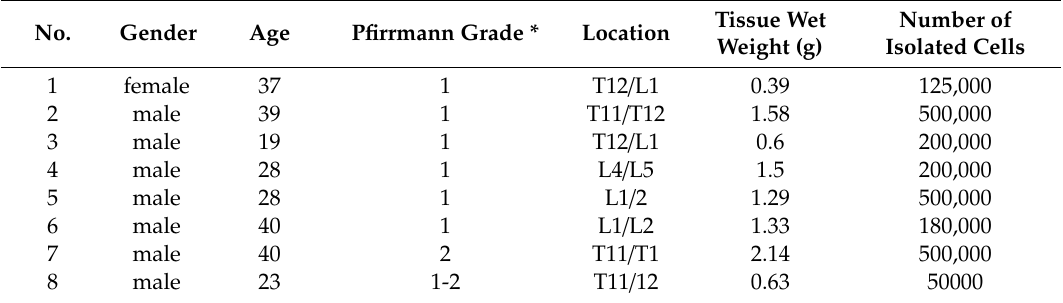
Table 1. Donor list with of gender, age, Pfirrmann grade, tissue weight, and the number of isolated